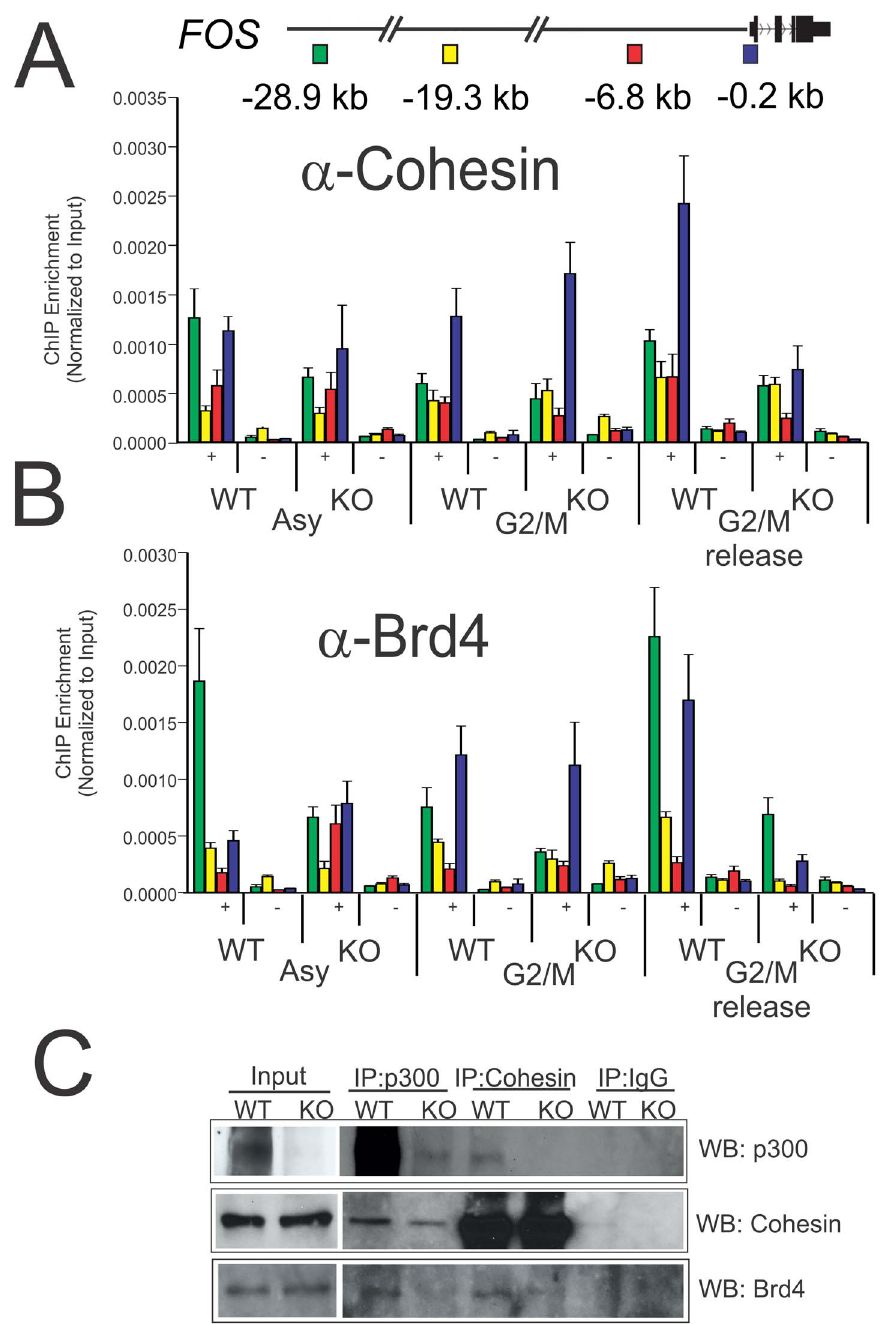
Figure 5. p300 is required for post-mitotic recruitment of Cohesin and Brd4. Jurkat p300 WT and p300 KO cells were elutriated to obtain cells of G2/M population and allowed to progress for 20 min to the G1 phase of the cell cycle. A schematic of the locations of enhancers ( 2 28.9 kb & 2 19.3 kb), upstream ( 2 6.8 kb) and promoter ( 2 0.2 kb) at the FOS locus relative to TSS as indicated. Position dependent profile at the FOS locus for (A) Cohesin and (B) Brd4 antibodies ( + ) and no antibody control ( 2 ) as indicated determined by quantitative ChIP analysis. Error bars represent standard error of the mean from 2 biological replicates each determined in duplicate. (C) ChIP-western showing p300 dependency for Cohesin and Brd4 interaction. Shown is 1 of 2 independent biological replicates. doi:10.1371/journal.pone.0099989.g005 pairs, the occupancy of Cohesin in control and p300 depleted G2/ M isolated Jurkat cells was compared following 2 h release into G1. Loss of p300 resulted in a significant decrease in recovery of Cohesin binding at the FOS promoter and upstream enhancer regions following mitotic exit and entry into G1 (Figure 5A).